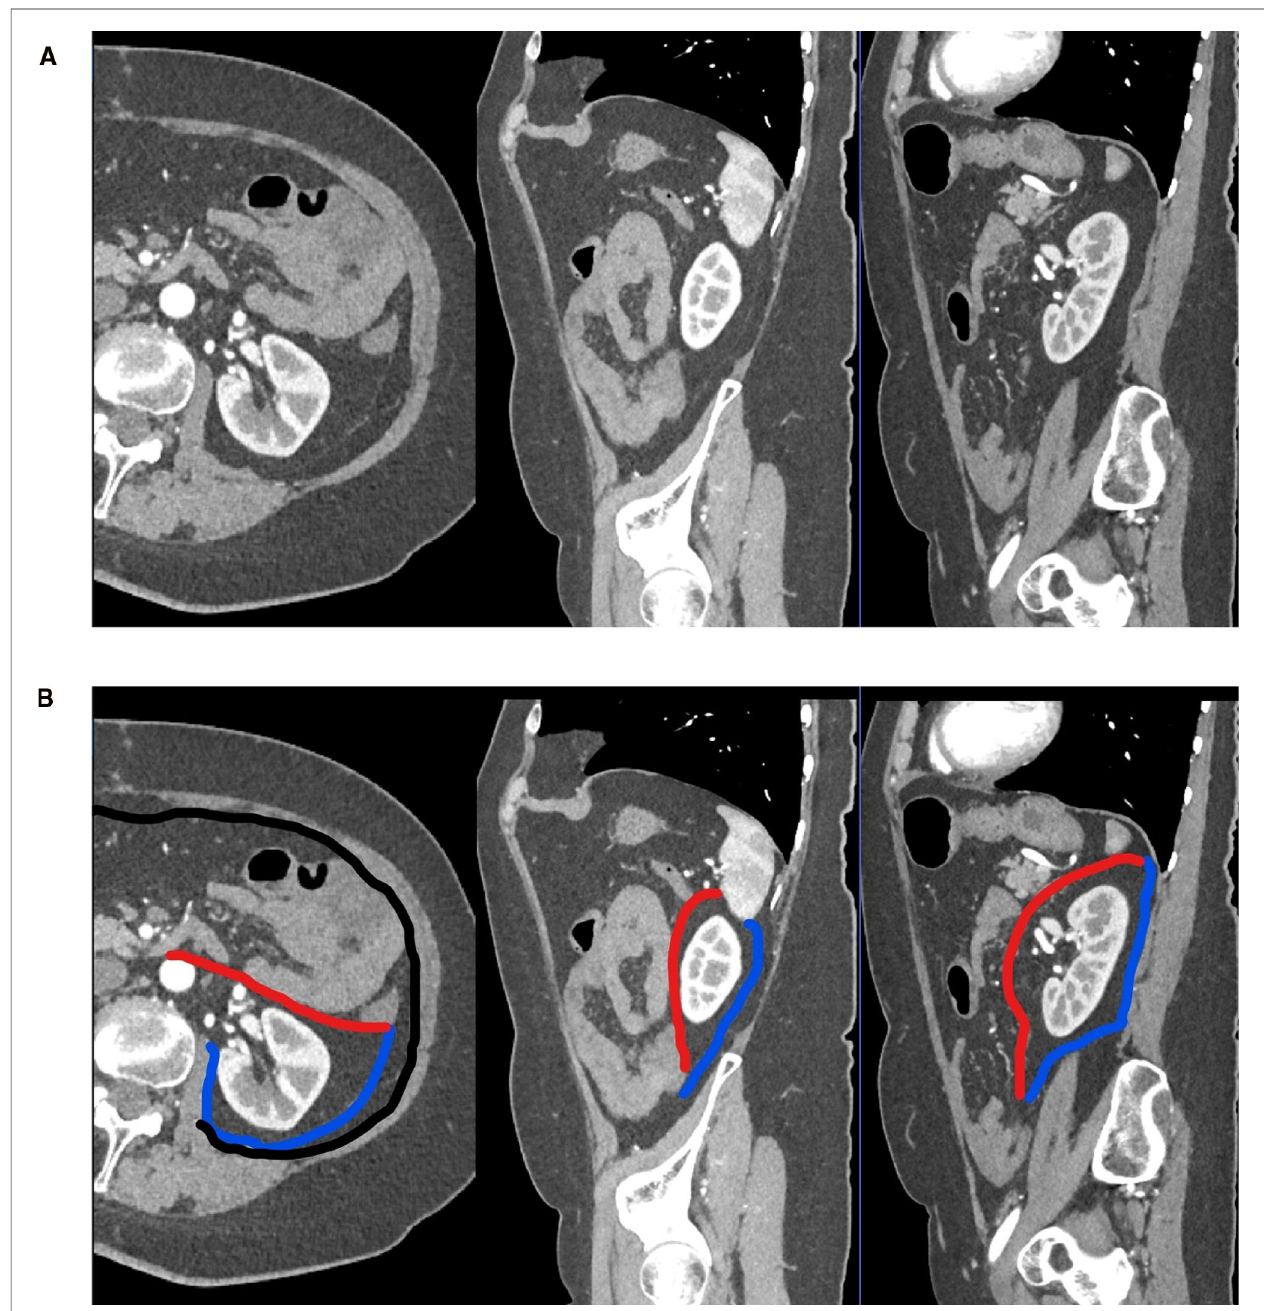
FIGURE 2 | Computed tomography imaging with a reconstruction of the transverse and sagittal planes with contrast enhancement ( A ) and emphasizing the perirenal fat pad and its limits. ( B ) Same images with the posterior renal fascia highlighted in blue, the anterior renal fascia in red, and TF in